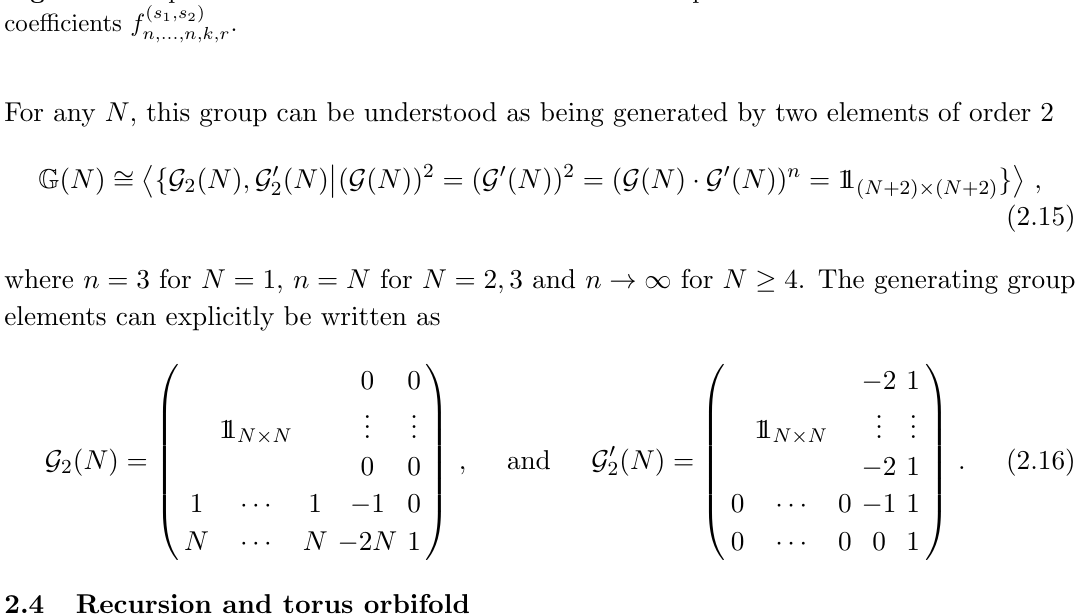
Figure 2 . Graphical overview of modular transformations for quasi-Jacobi forms created from